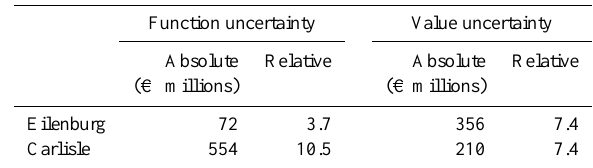
Table 5. Results for function uncertainty and value uncertainty for Eilenburg and Carlisle. Function uncertainty is calculated by keep- ing a constant maximum damage value while using the various depth–damage functions from all models. Value uncertainty is cal- culated by keeping a constant depth–damage function while apply- ing the various maximum damage values (Fig. 8). Absolute uncer- tainty is calculated by subtracting the lowest from the highest model estimate, while relative uncertainty is obtained by dividing the low- est by the highest